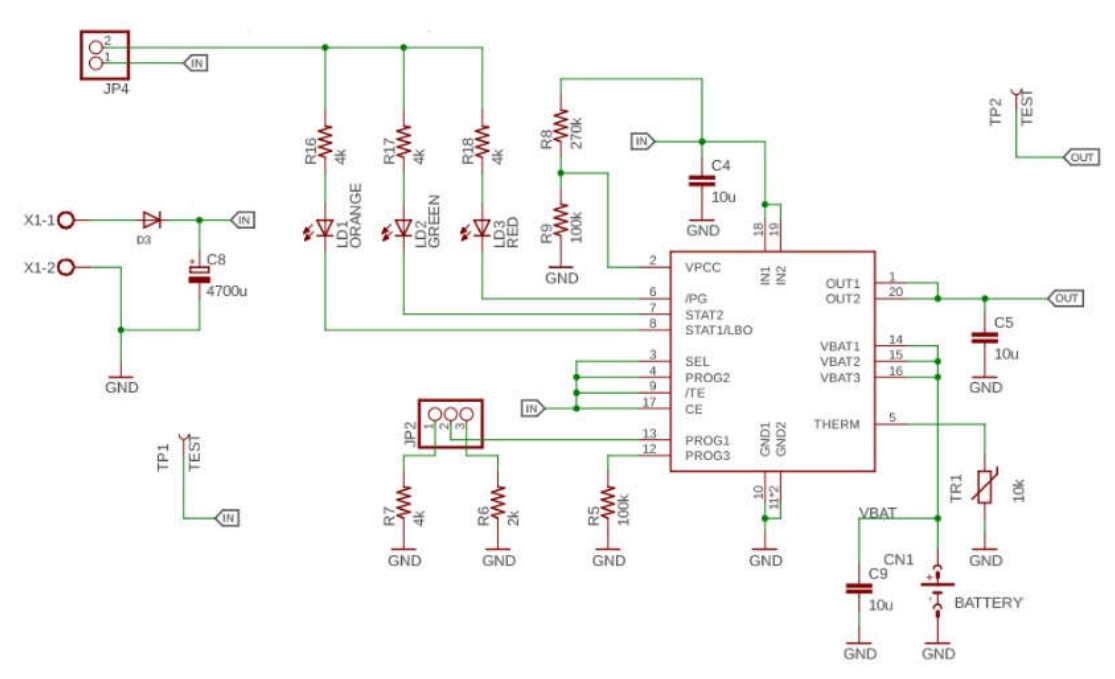
Figure 4. Schematic of the charger section.